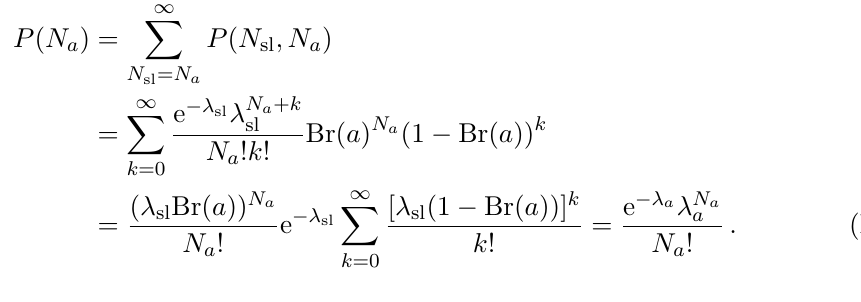
Figure 11 . Number of events expected at the FCC-ee with consistent with leptogenesis. Left and right panel correspond to normal and inverted mass ordering,